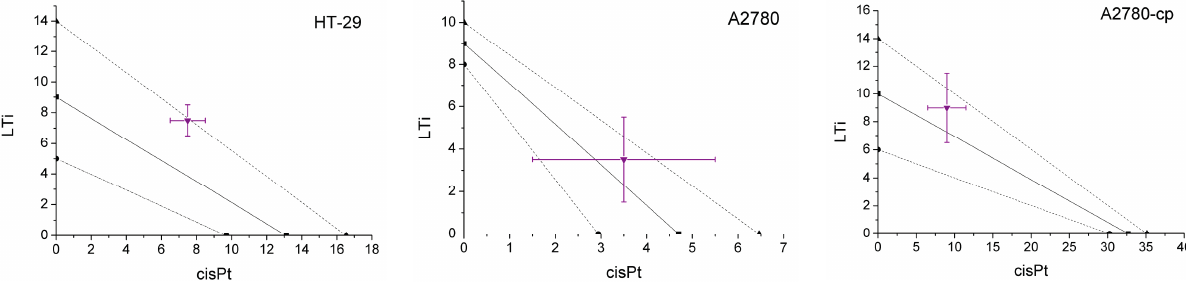
Figure 2. Isobolographic analysis of the cytotoxicity of the combination of LTi and cisplatin, at 1:1 ratio, toward human colon HT-29, ovarian cisplatin-sensitive A2780, and -resistant A2780-cp cell lines. The IC 50 values of the compounds alone are the axial points, connected to provide the additive line with its error range. Results within the additive range indicate additive behavior, those below indicate synergism, and those above indicate